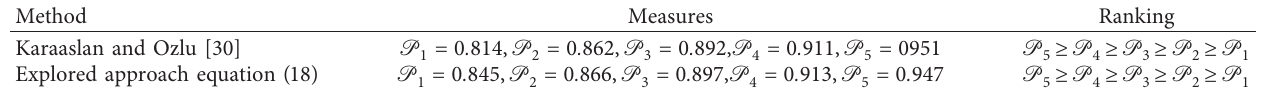
Table 4: Comparison of the explored work with existing work.